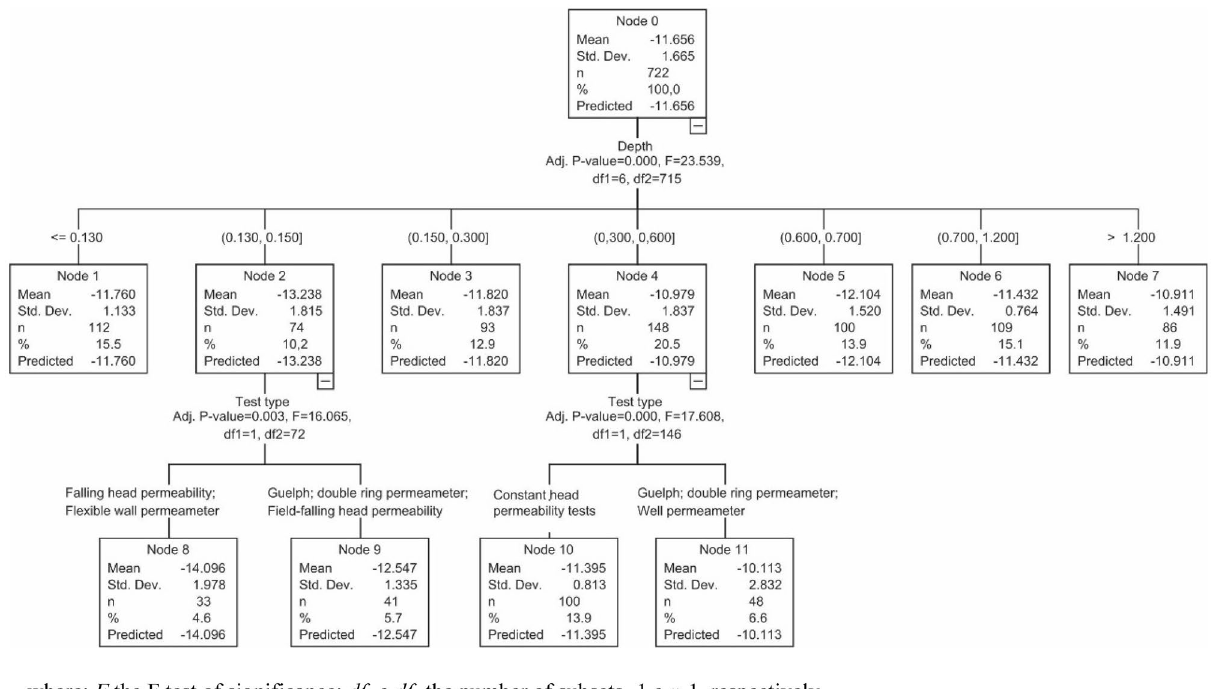
Figure 10. CHAID decision tree for hydraulic conductivity values of Brazilian lateritic soils